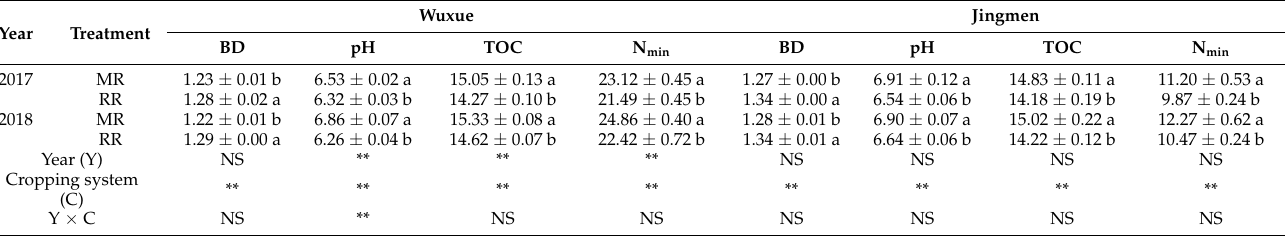
Table 7. Soil properties after the first crop harvest at both experimental sites in 2017 and